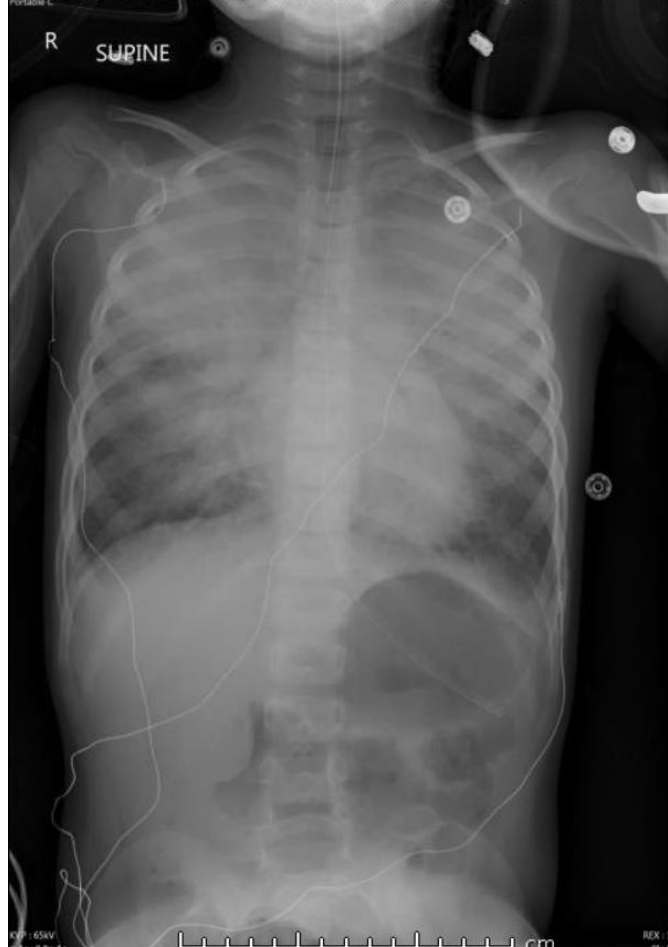
Image 3. Post-Intubation chest radiograph demonstrating worsen- ing edema consistent with acute respiratory distress